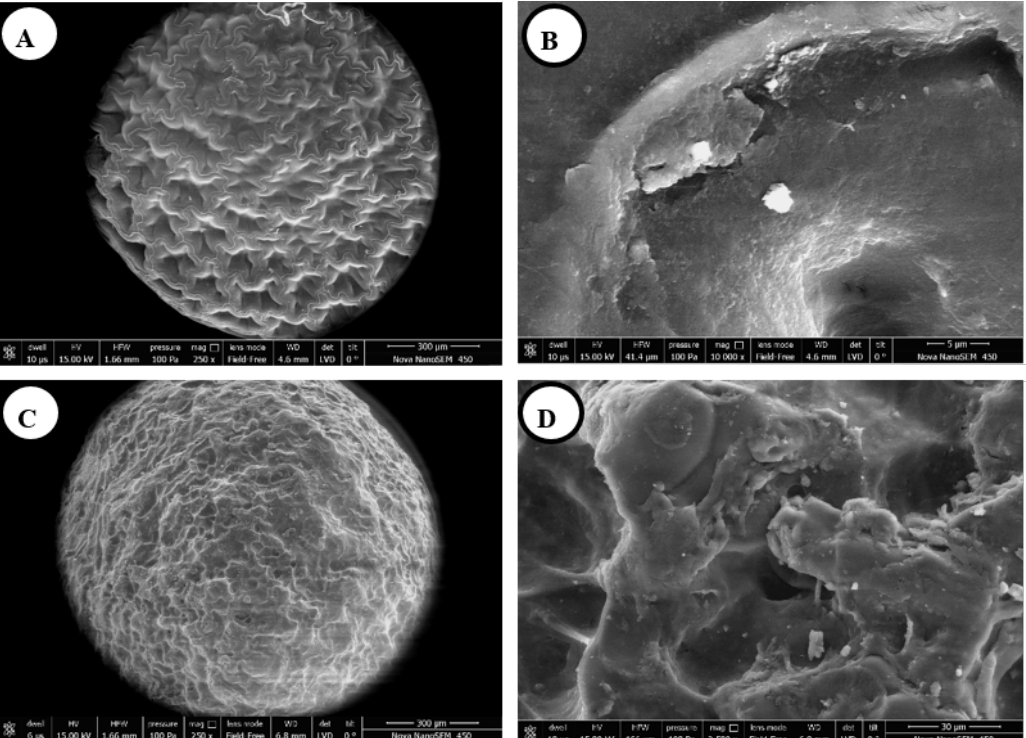
Figure 2: Scanning electron micrographs of Physalis spp. seed: (A) seed surface of P. peruviana (x250); (B) cell lumen with cell boundaries of P. peruviana (x10000) (C) seed surface of P. pruinosa (x250 and (D) cell lumen of P. pruinosa